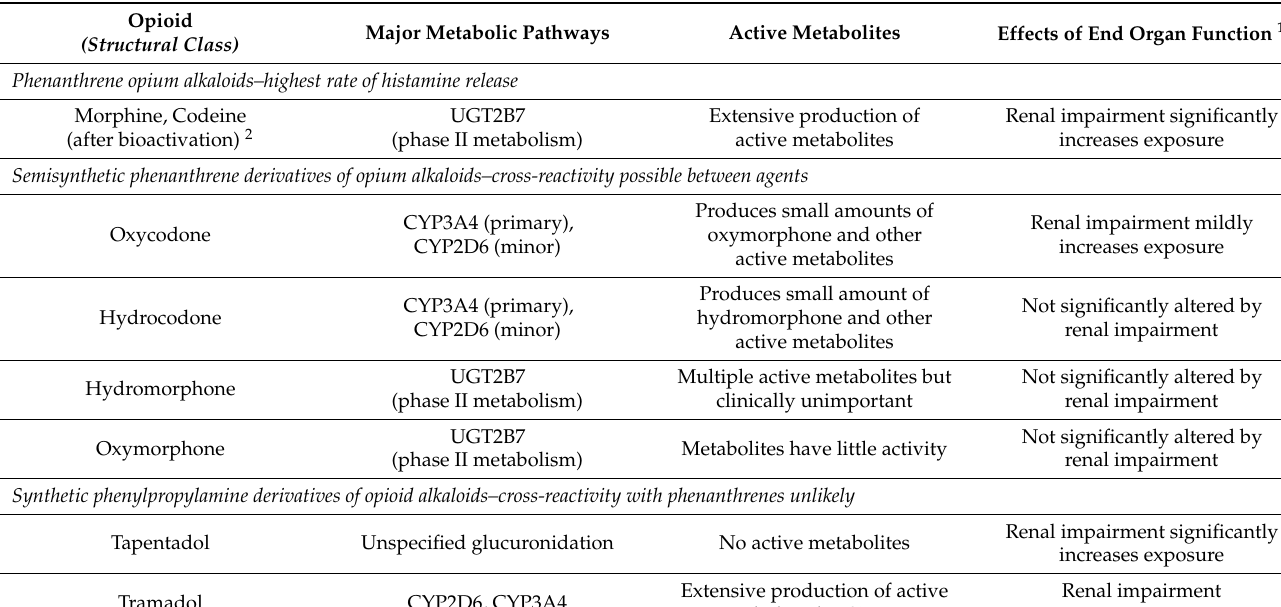
Table 9. Opioid Properties to Consider When Selecting or Modifying Postoperative